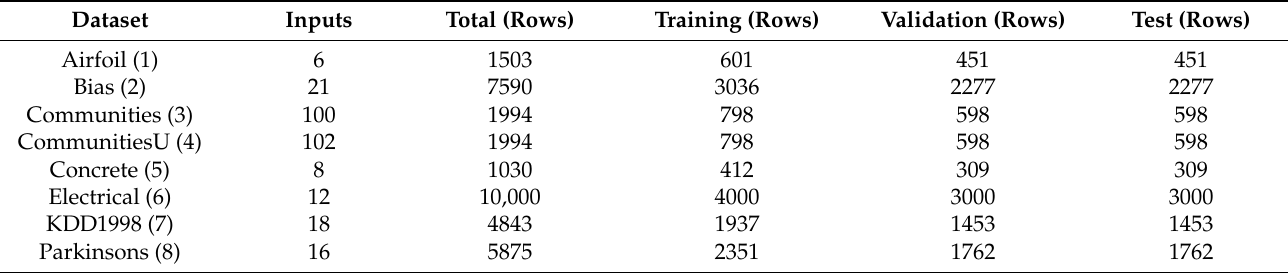
Table 2. Datasets selected from UCI